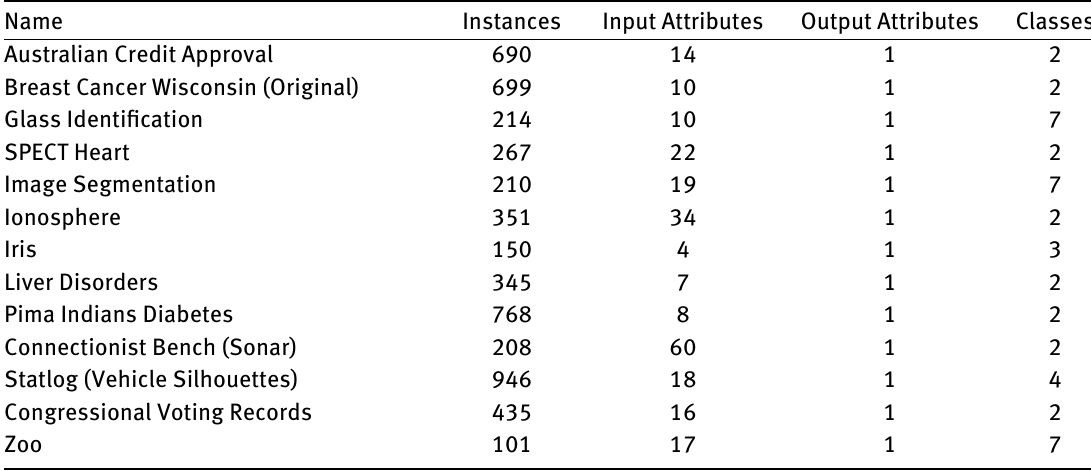
Table 1: UCI Benchmarked Datasets used in our